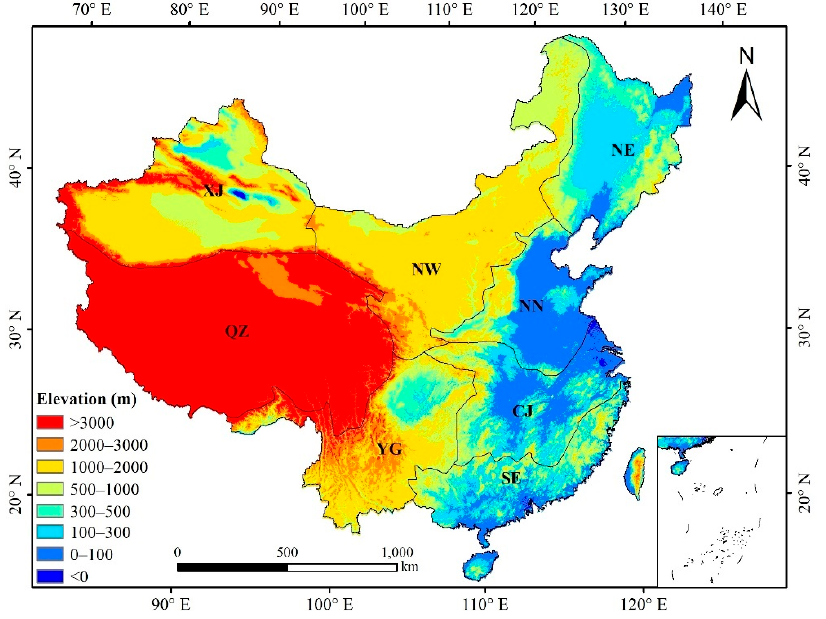
Figure 1. Eight subregions of the study area and their elevation: Xinjiang (XJ), Qinghai–Tibetan Plateau (QZ), Northwest China (NW), Northeast China (NE), North China (NN), southwest Yungui Plateau (YG), the plains region of Changjiang (Yangtze) River (CJ), and Southeast China